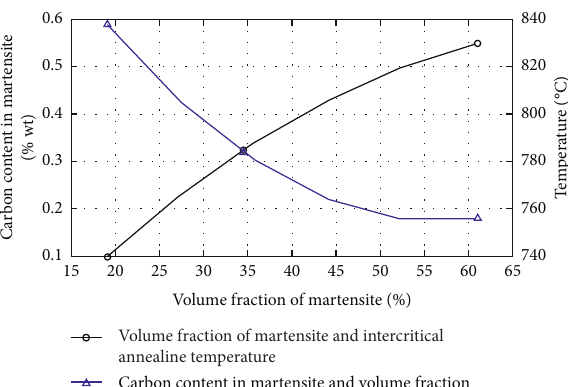
Figure 7: Dependence of volume fraction and carbon content of martensite on intercritical annealing temperature.